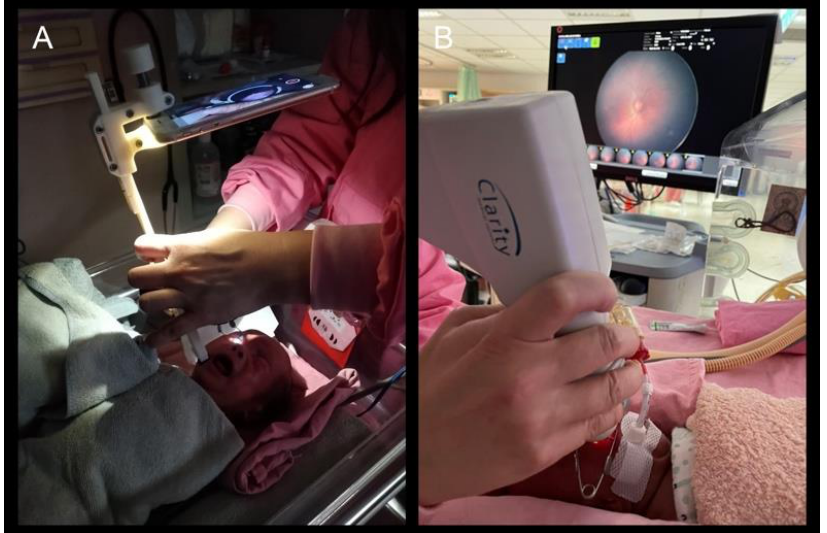
Figure 2. Image systems used in the study. ( A ) Smartphone-based fundus photography capture system (C3 Funduscam). ( B ) Wide-angle contact imaging system